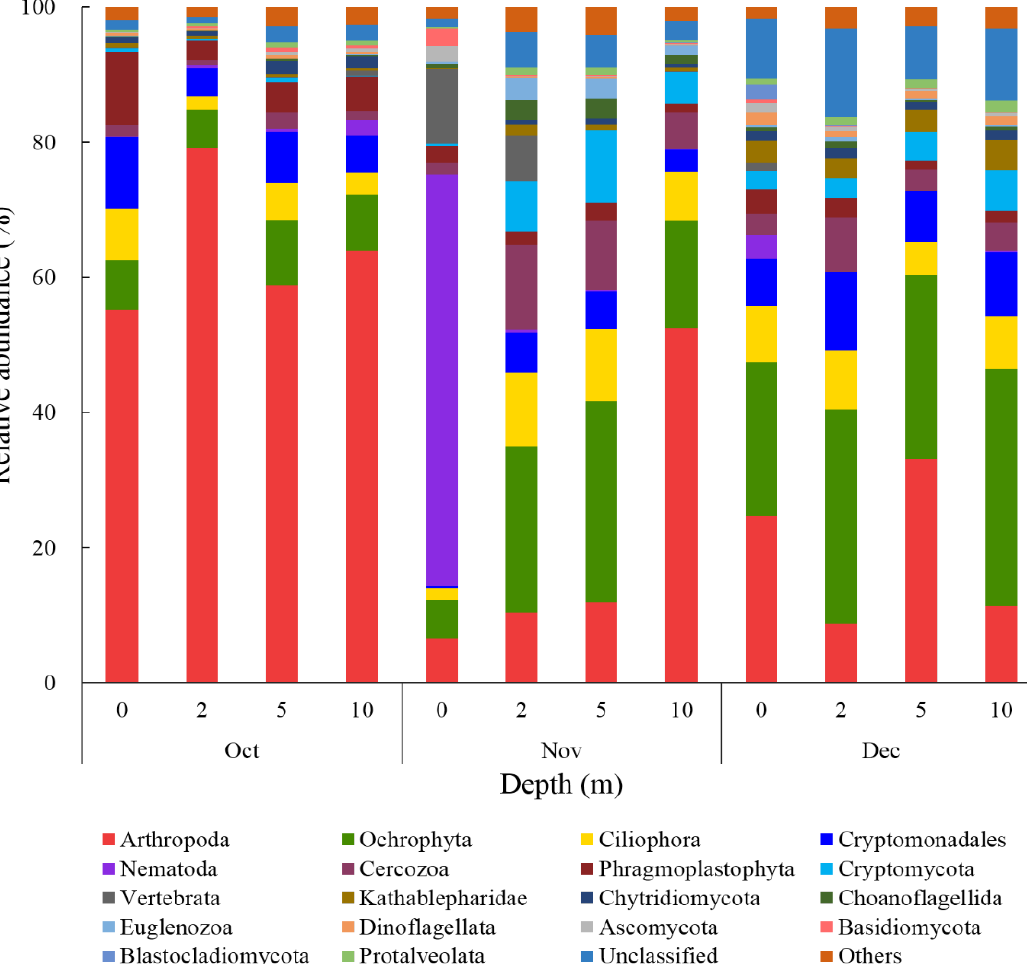
Figure 6. Eukaryotic microorganism community compositions at phylum levels (top 18) in